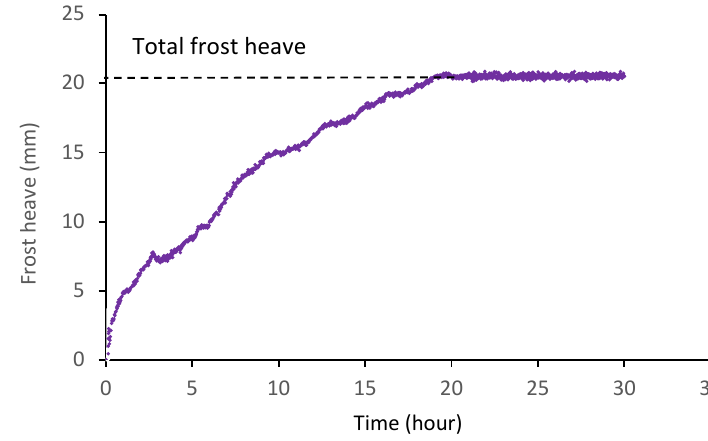
Fig. 3 : Diagram of time and frost heave for the untreated soil sample